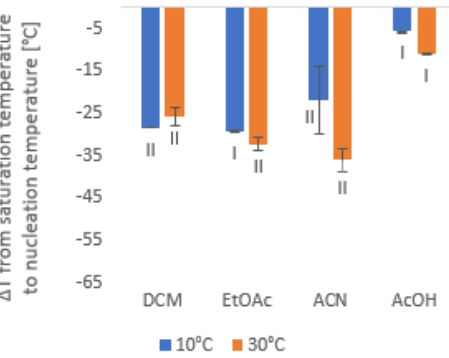
Figure 5. (1-column fitting) Metastable zone width (MSZW) of piroxicam in different solvents. Polymorphism of the obtained solid is also shown in the figure. Saturated solutions at 10 and 30 ◦ C have been used, respectively. DCM (dichloromethane), EtOAc (Ethyl Acetate), ACN (Acetonitrile) and AcOH (Acetic Acid).